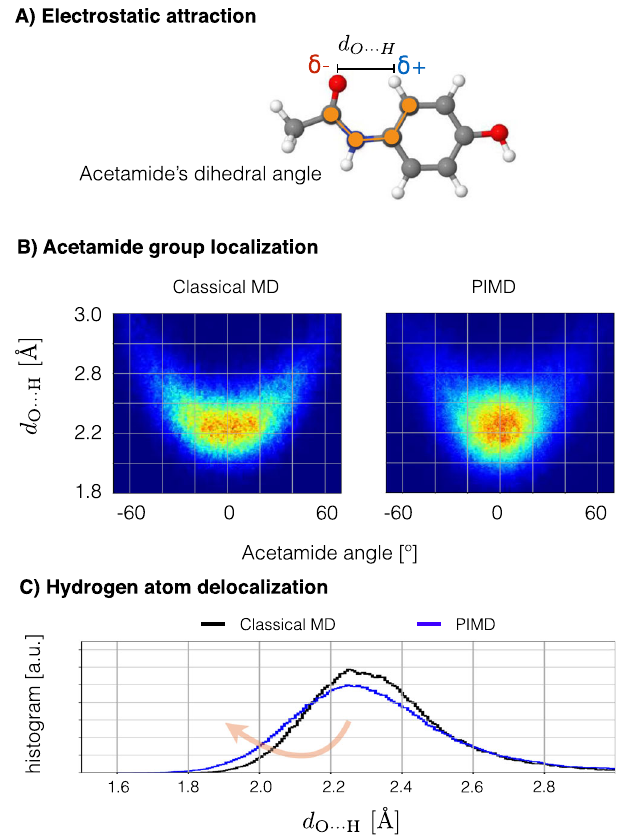
Fig. 4 Strengthening of electrostatic interactions in paracetamol molecule by proton delocalization. A Graphical representation of the paracetamol molecule. B Effective free energy surface generated from classical MD and PIMD at room temperature using the sGDML@DFT(PBE0 + MBD) force fi eld. C Interatomic distance distribution d O ⋯ H generated from classical MD (black) and PIMD